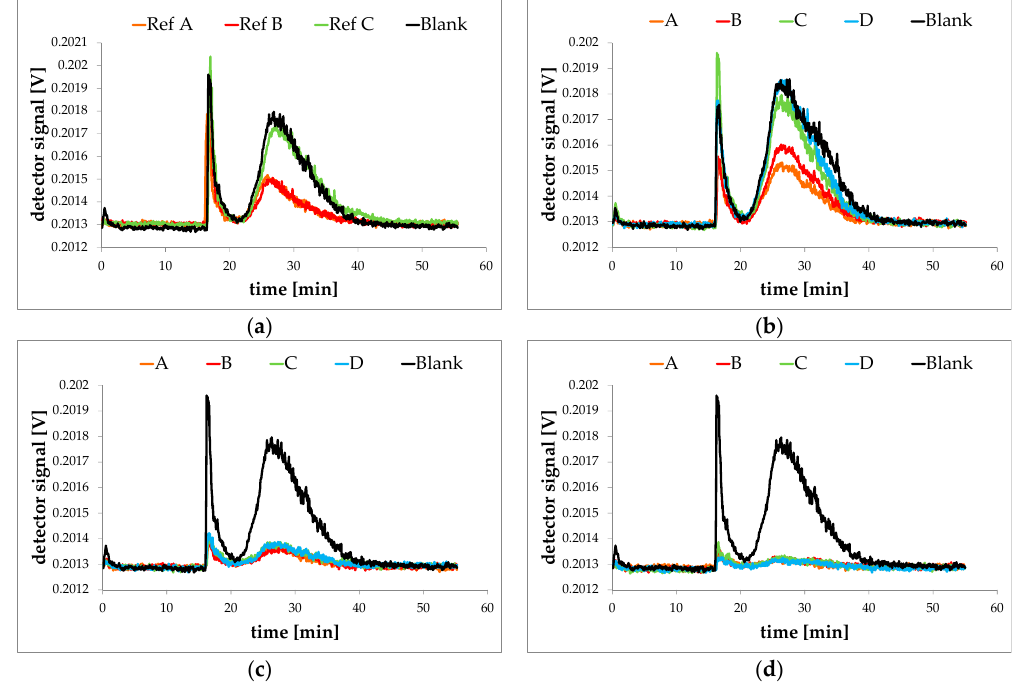
Figure 5. AF4/MALLS fractograms of the migration samples. ( a ) LDPE reference samples without laponite as well as nanocomposites with ( b ) 2% laponite; ( c ) 4% laponite and ( d ) 6% laponite. The black fractograms are the 2000 mg/L Novachem simulant blank that was stored for 10 d at 60 °C.